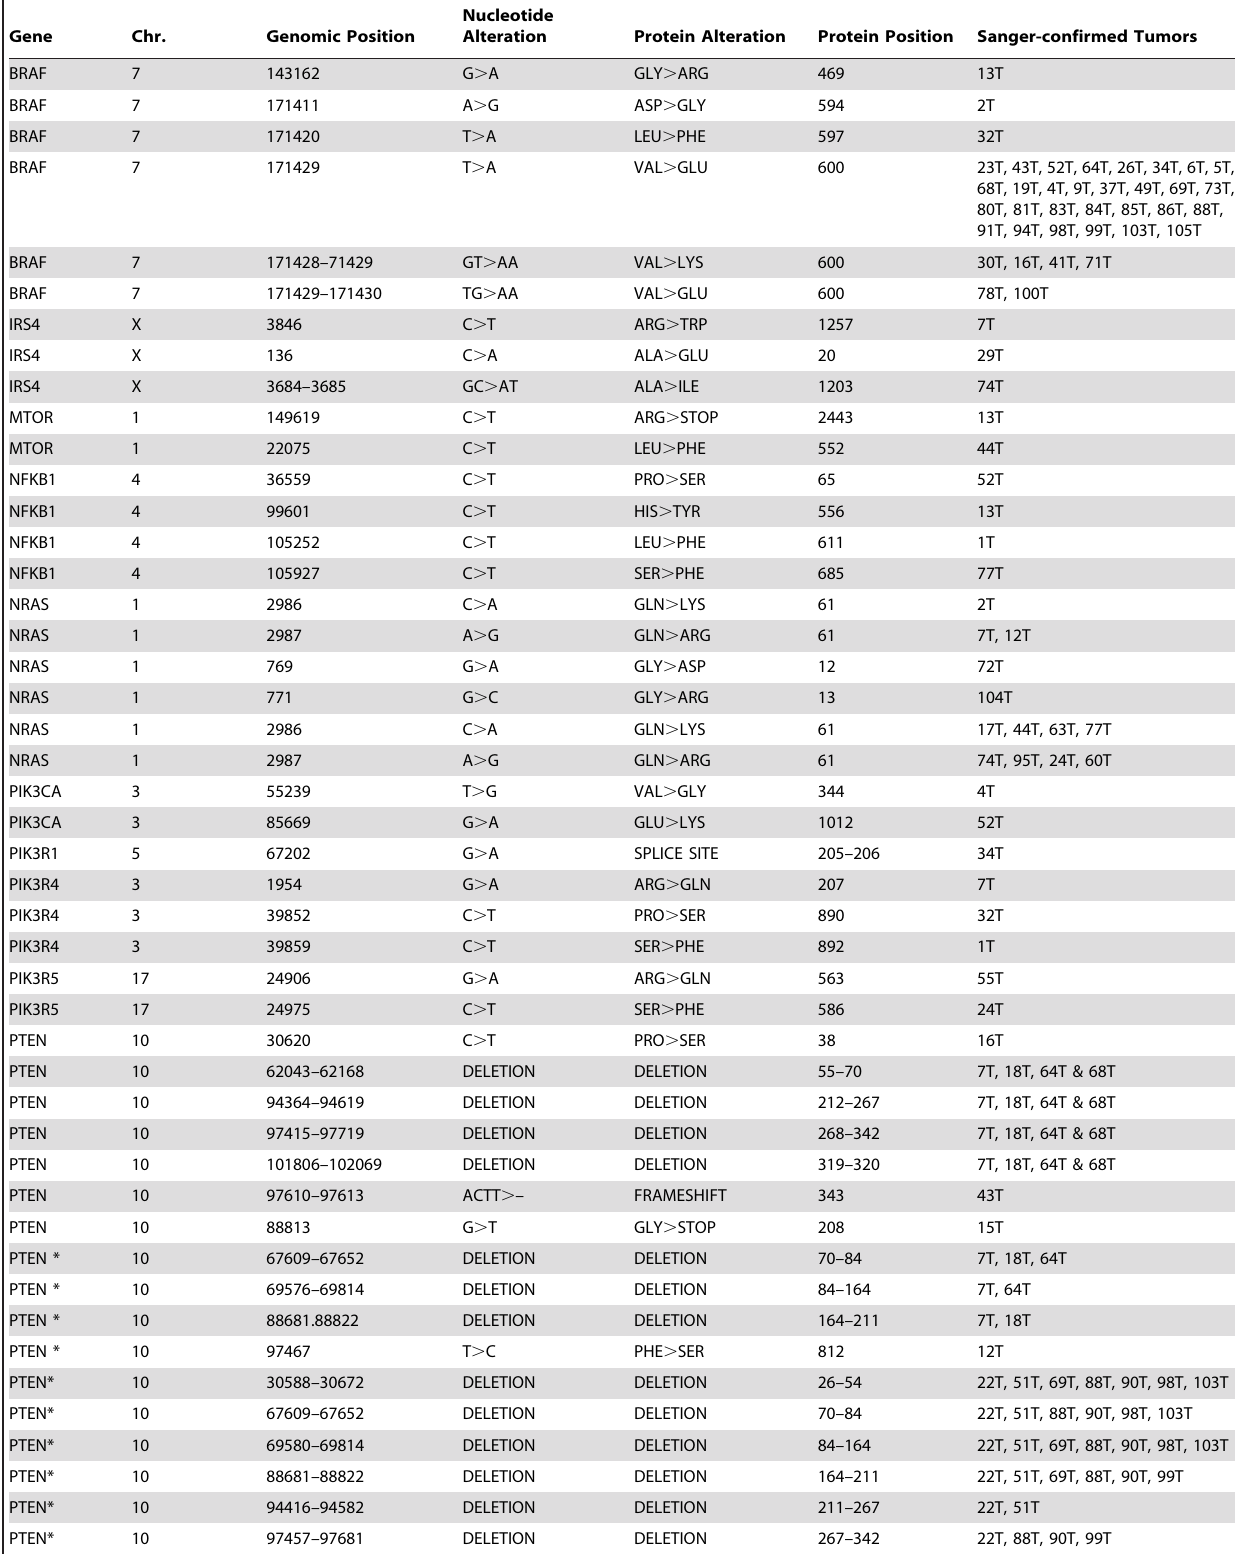
Nucleotide Alteration Protein Alteration Protein Position Sanger-confirmed Tumors